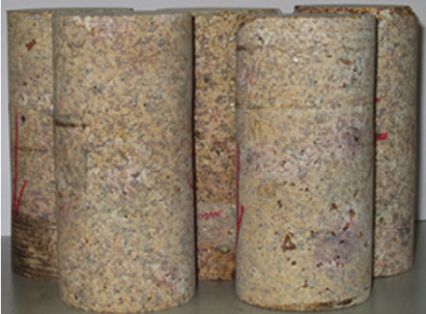
Figure 1: Granite samples for testing.